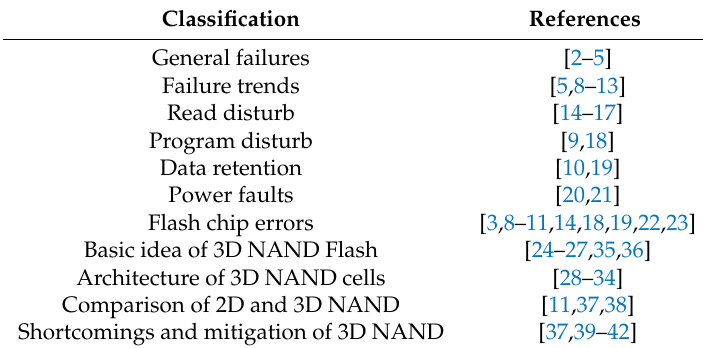
Table 1. A classification based on different research categories of NAND